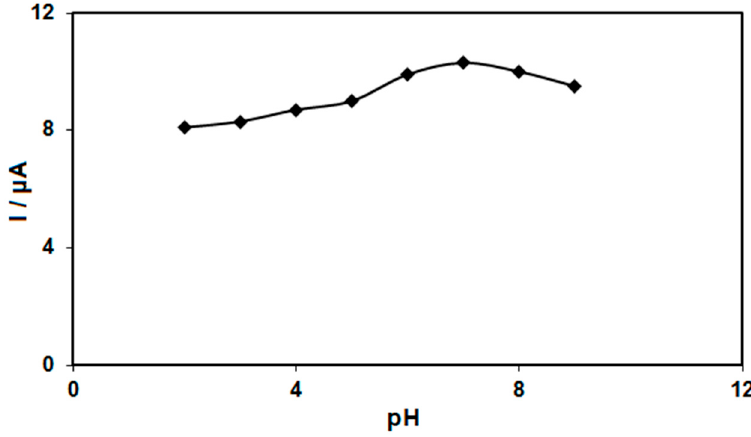
Figure 5. Plot of Ip vs. pH obtained from DPVs of graphene-Co 3 O 4 /SPGE in a solution containing 200.0 µM of morphine in 0.1 PBS with different pHs (2.0, 3.0, 4.0, 5.0, 6.0, 7.0, 8.0 and 9.0).